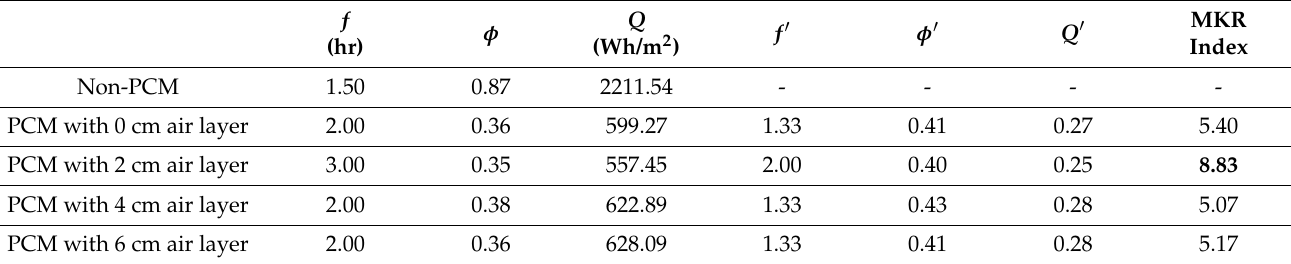
Table 2. MKR index for all configurations of